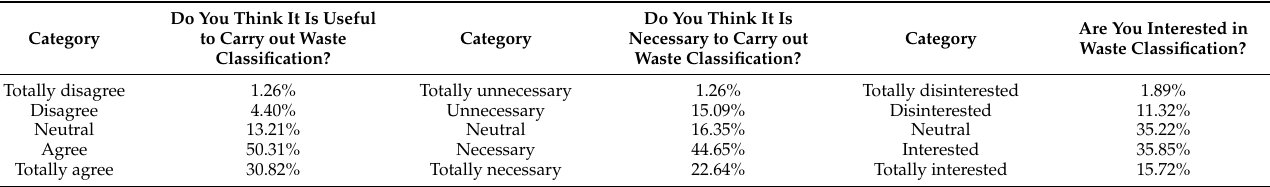
Table 5. Famers’ attitudes toward waste